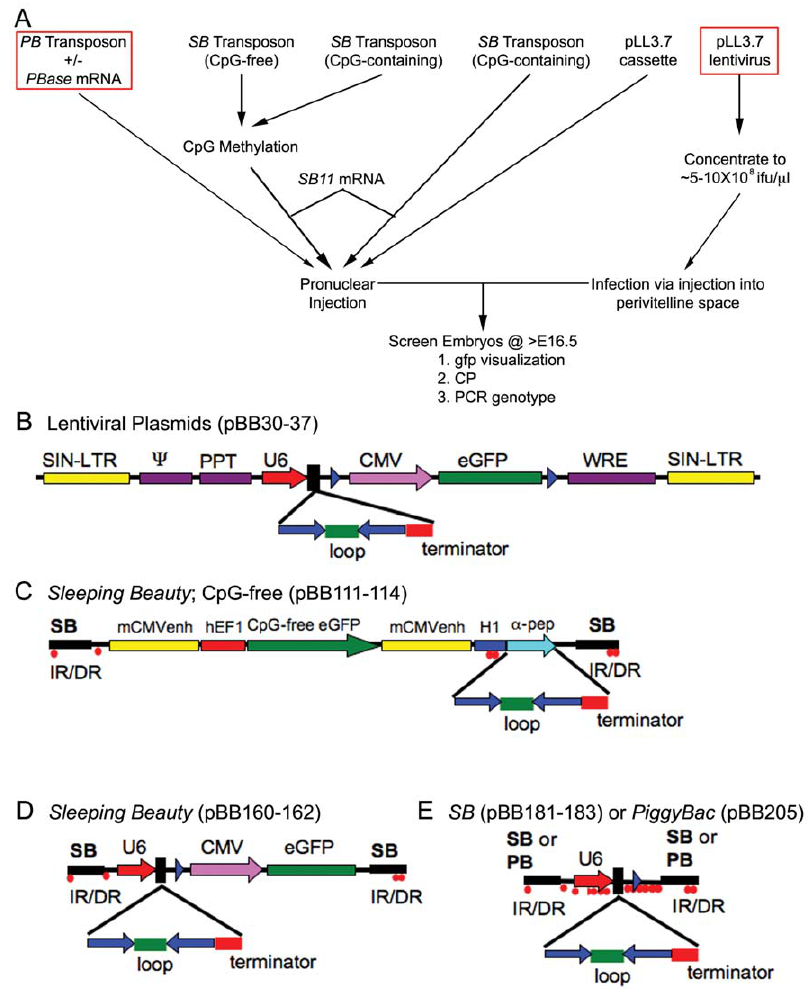
Figure 3. Strategy for gene mutation validation and candidate gene screening using transient transgenic RNAi knockdown. Flow chart outlining the experimental method and the classes of transgenic delivery vehicles and their variants ( A ). Creation of various shRNA-expressing lentivirus and Sleeping Beauty ( SB ) and PiggyBac ( PB ) transposon plasmids ( B–E ). B ) pLL3.7 lentivirus plasmid was described previously and contains a U6–shRNA; CMV-eGFP expression cassette [10]. SIN-LTR, self-inactivating long terminal repeat; Y , HIV packaging signal; cPPT, central polypurine track; MCS, multiple cloning site; CMV, cytomegalovirus promoter; WRE, woodchuck hepatitis virus response element. Sense and antisense sequences that form the stem of the stem loop shRNA sequence are shown by the solid blue arrows; the loop sequence, green bar and the terminator, red bar. C ) CpG-free EF1-GFP; H1-shRNA SB transposons. IR/DR, inverted/direct terminal repeats recognized by SB transposase; mCMVenh, mouse cytomegalovirus enhancer sequence; hEF1, human EF1 promoter; eGFP, synthetic GFP coding sequence; H1, human pol III promoter; a -pep, lacZ alpha peptide for blue-white selection. D ) CpG-containing U6-shRNA; CMV-eGFP from pLL3.7 in the SB transposon. E ) U6-shRNA expression cassette from pLL3.7 in the SB and PB transposons. CpG dinucleotides methylated by SssI methylase (red dots) in SB transposon experiments are shown.